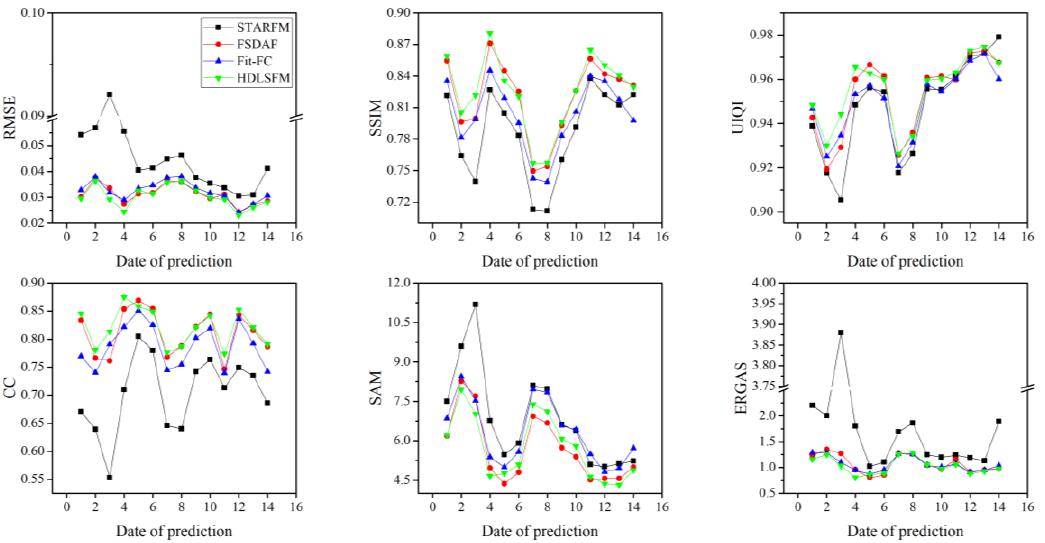
Figure 9. Prediction results of different STF methods for all prediction dates in the fused time series data of the Coleambally irrigation area (CIA) site.